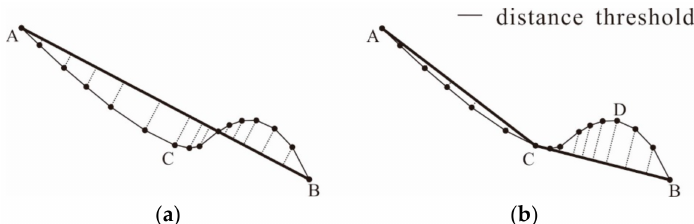
Figure 7. Extraction of terrain feature points based on the D–P algorithm: ( a ) feature point C is derived from start and end nodes A and B and ( b ) feature point D is derived from segment